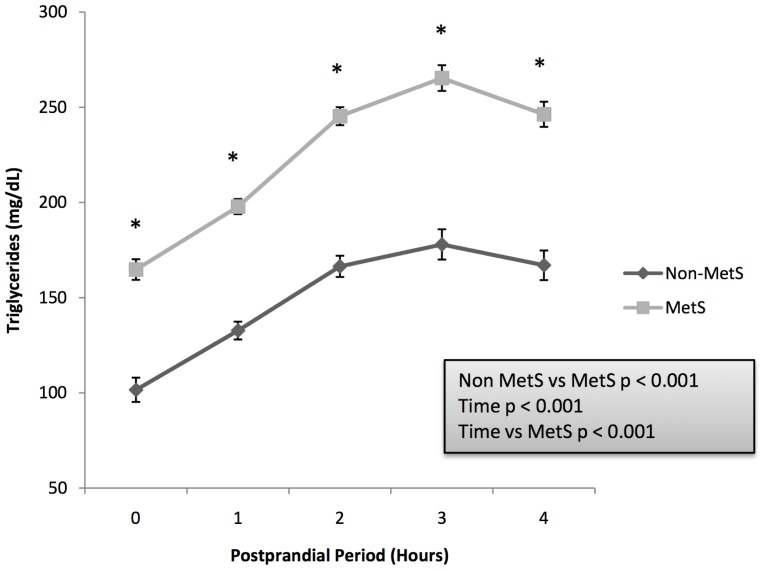
Plasma levels of triglycerides (mg/dL) during postprandial period in patients with and without MetS.MetS patients showed higher plasma levels of triglycerides in each of the time points performed during the postprandial period (p<0.001). Results are plotted as Mean±SE. Variables were compared using repeated measured ANOVA, with sex and age as covariates.